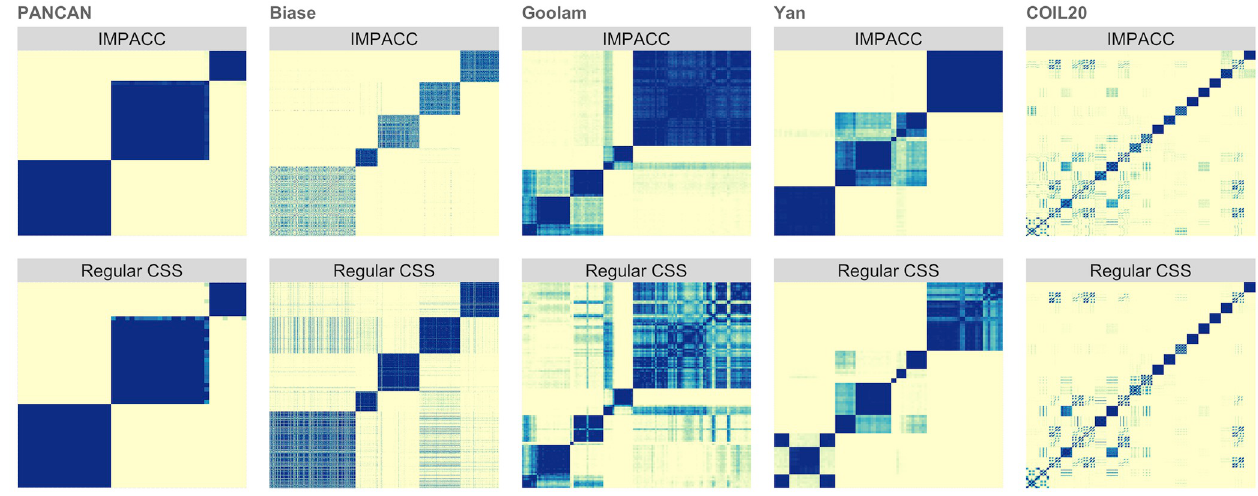
Fig 2. Heatmaps of final consensus matrix derived from IMPACC and consensus clustering respectively, using oracle number of clusters. Darker color indicates higher consensus value.